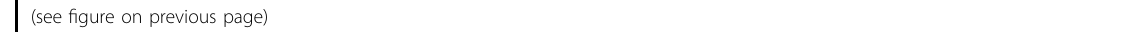
Fig. 3 The vascular endothelium is a double-layered barrier for neutrophil extravasation. a Transmission electron microscopy revealed a gradual intrusion of neutrophils into the endothelial cell layer (upper panel). The cartoons of the transmission electron micrographs from the upper panel indicate the endothelial cell layer in red and pericytes in blue (lower panel). b Two-photon three-dimensional microscopy revealed the presence of transendothelial migratory neutrophils. See Video 4. c Transmission electron microscopy revealed neutrophil embedment in the endothelial basement between the endothelial cell layer and pericytes (upper panel). The cartoons of the transmission electron micrographs from the upper panel indicate the endothelial cell layer shown in red and pericytes in blue (lower panel). d Two-photon intravital microscopy revealed that neutrophils were embedded in the endothelial basement membrane. See Videos 5 and 6. e Transmission electron microscopy revealed that neutrophils penetrated the pericyte sheath. (1) The leading edge of an embodied neutrophil protruded from the endothelial basement membrane between the endothelial cell layer and the pericyte sheath. (2) Two neutrophils were undergoing penetration at the same site of the pericyte sheath in the panel. (3) Three neutrophils were undergoing penetration at the same site of the pericyte sheath in the panel. (4) The head and tail regions of a neutrophil are localized outside the pericyte sheath in the panel. In all of the corresponding cartoons, the endothelial cells are shown in blue, and the pericytes are in red. Blue and red arrows indicate endothelial cells and pericytes, respectively. N neutrophil, Lu lumen. f Two-photon intravital microscopy revealed three neutrophils that were continually penetrating the vascular endothelium at the same spot within 5 min of each other. The dotted arrows indicate the trajectories of the extravasating neutrophils. See Video 7. For all experiments, the data are representative of fi ve independently repeated experiments with N -formylmethionyl-leucyl-phenylalanine